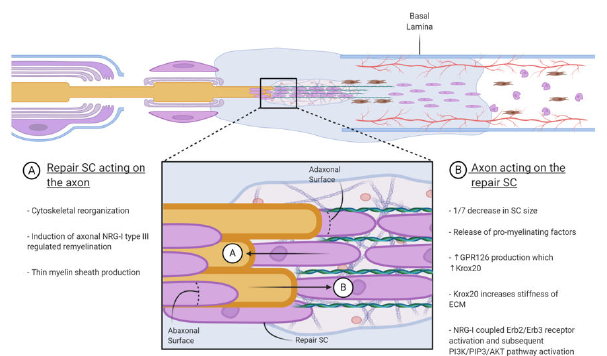
Figure 4. The contact with regrowing axons initiates remyelination. The figure was adapted from “Peripheral Nervous System (PNS) Myelin Structure” by BioRender.com (accessed on 2020). NRG-I, Neuregulin-I: ECM, extracellular matrix; GPR126, G protein-coupled receptor